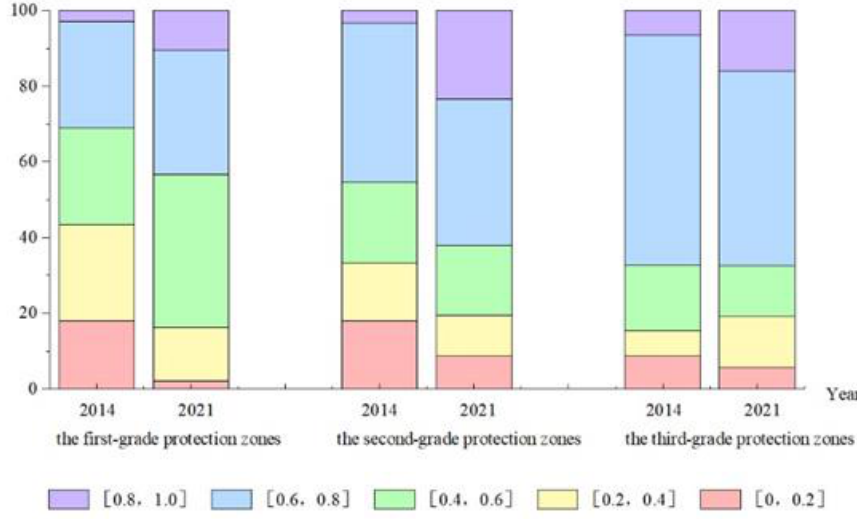
Figure 4. Percentage accumulation map of eco-environmental quality in different governance areas from 2014 to 2021.